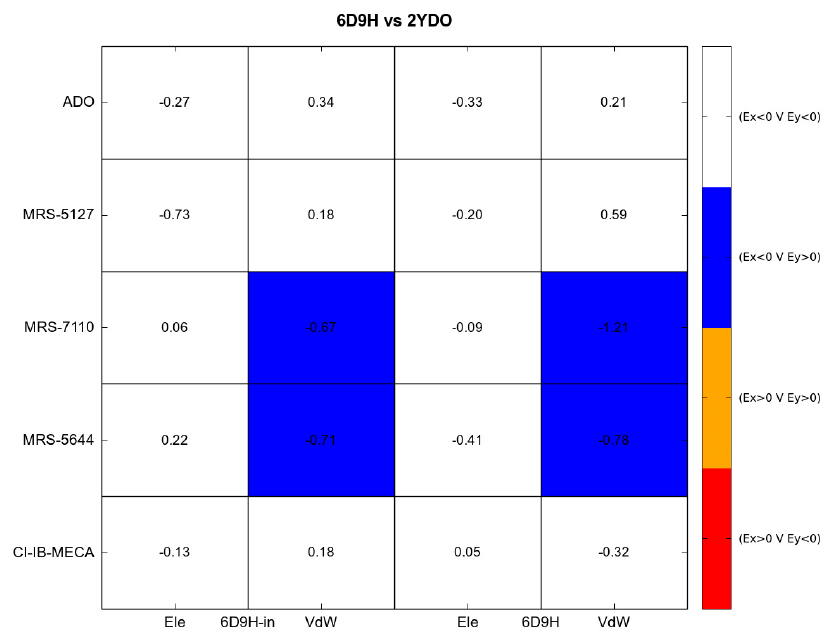
Figure 7. EM correlation matrix of energy contributions (electrostatic and van der Waals) for agonist poses ( y -axis) obtained from the hA 1 -based model with induce fit (6D9H-in) and without induce fit (6D9H), as compared to the reference model (2YDO).